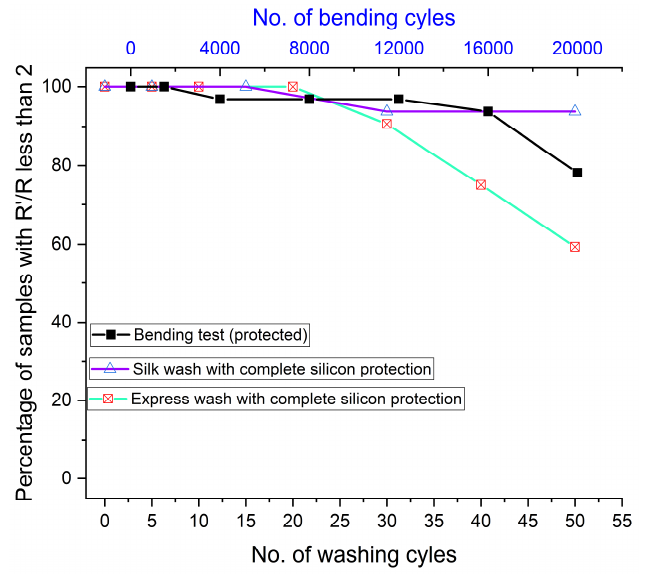
Figure 15. The comparison of completely protected washed and bending test samples.